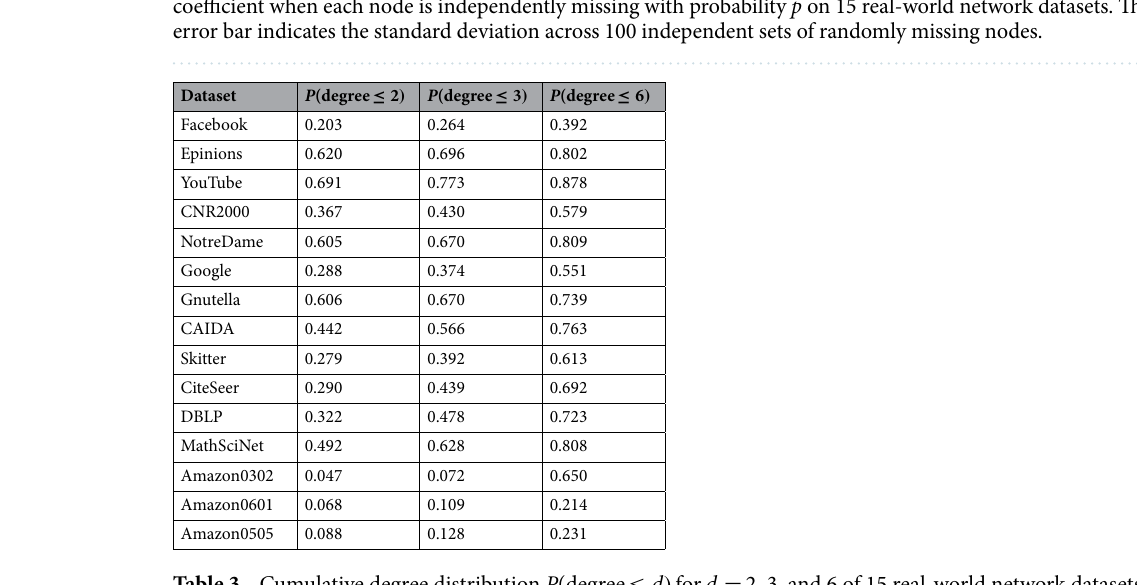
Table 3. Cumulative degree distribution P (degree ≤ d ) for d = 2, 3, and 6 of 15 real-world network datasets.